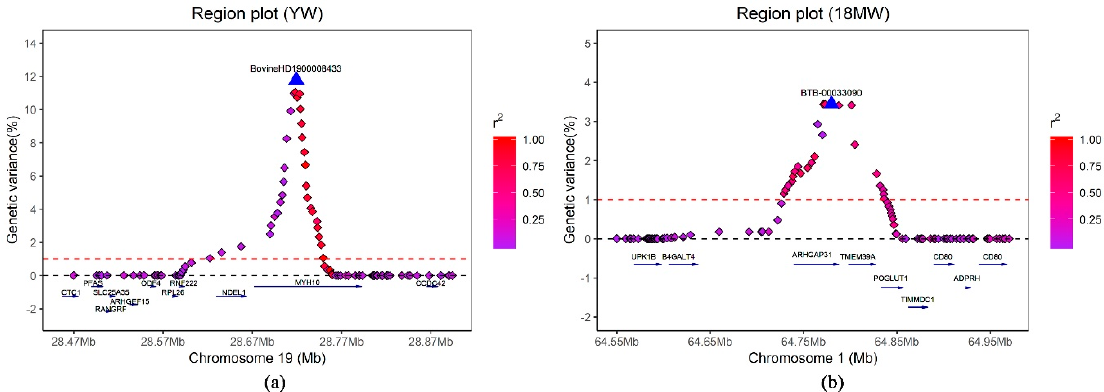
a Chromosomes; b Window position in Ensembl; c The proportion of the genetic variance explained by 20 adjacent SNP window; d The SNP that explained the largest proportion of genetic variance within each window (equal to the value of the 20 adjacent SNP window explained); e Candidate genes near the top SNPs.